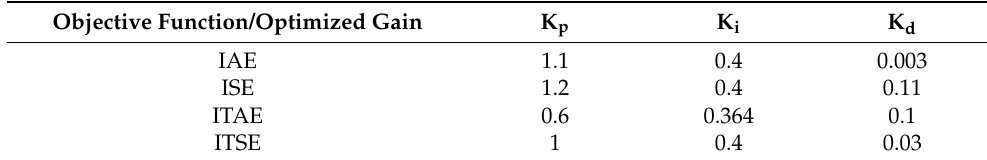
Table 2. Gain values of the conventional PID controller.